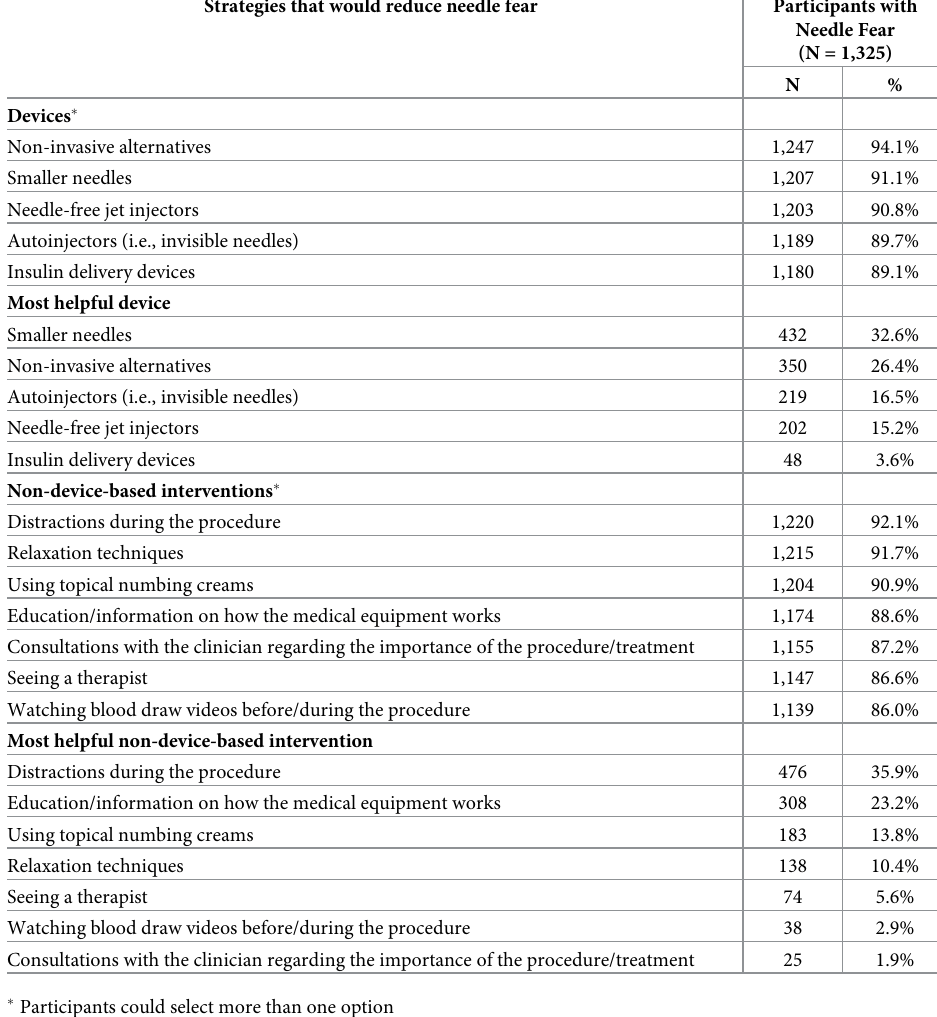
Table 3. Device and non-device-based strategies that would reduce needle fear of